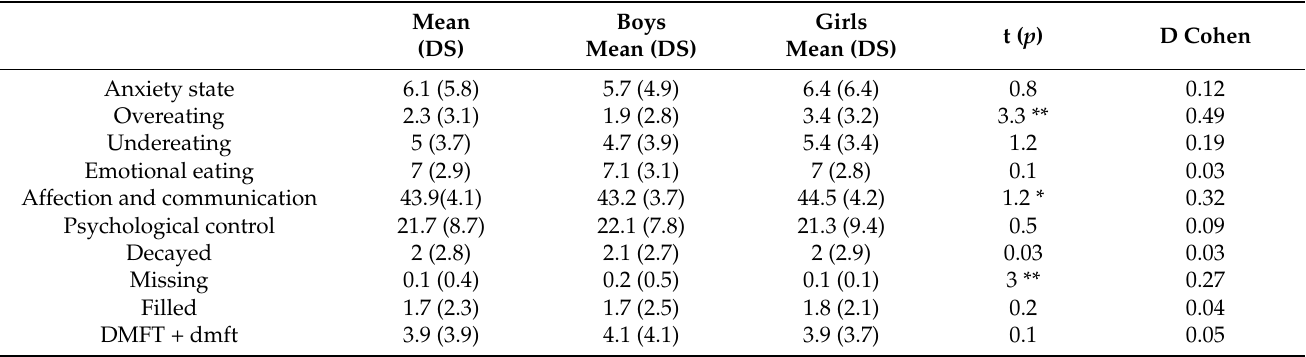
Table 1. Mean and standard deviation in decayed, missing, filled, DMFT + dmft, anxiety state, overeating, undereating, emotional eating, affection and communication, and promotion of autonomy. Comparative by